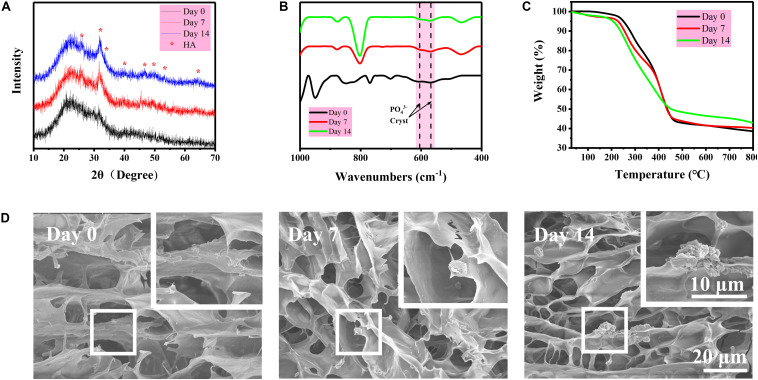
(A) XRD diagrams of freeze-dried DN/BG gel after different days of mineralization in SBF; (B) FTIR spectra of freeze-dried DN/BG gel after different days of mineralization; (C) TGA traces; and (D) SEM images of freeze-fractured DN/BG gel after different days of mineralization.